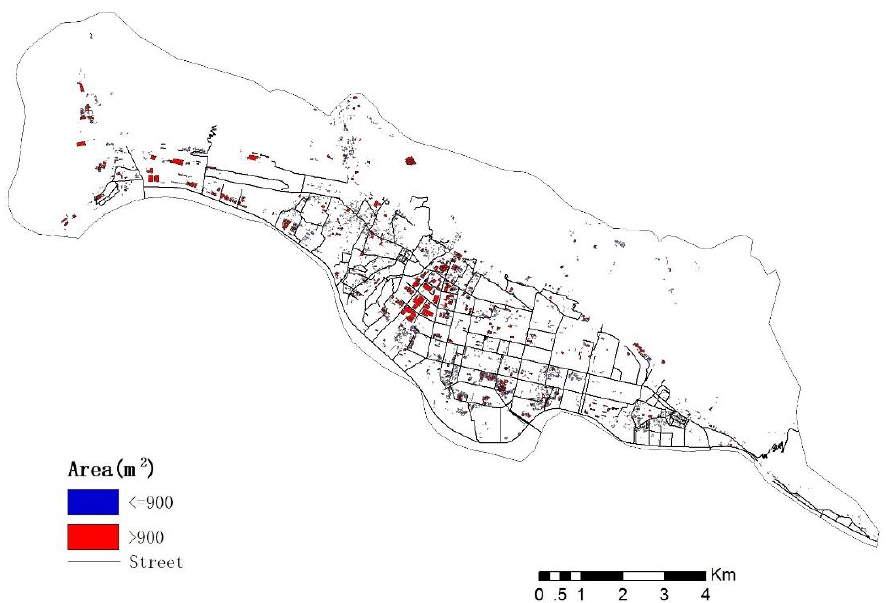
Figure.3 Extraction results of the color steel buildings in Anning District, Lanzhou City